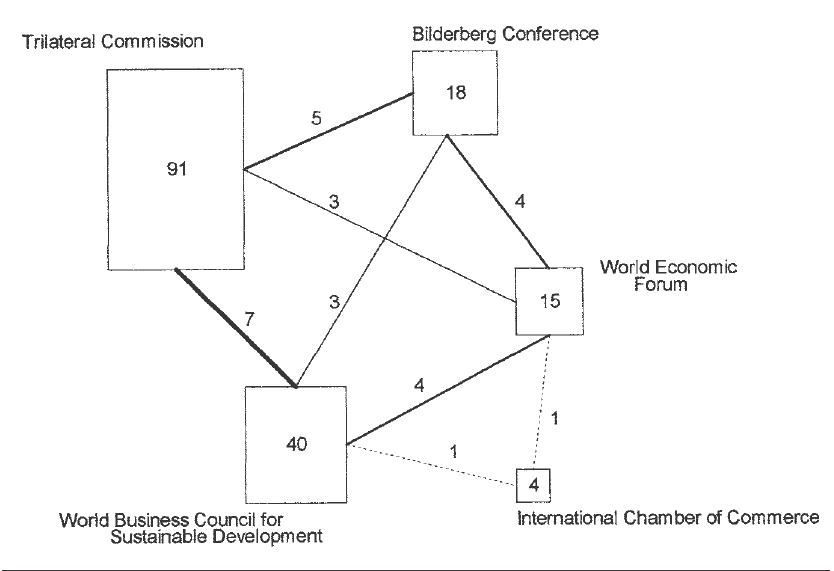
Figure 3 – Number of Interloks Among Five Global Policy